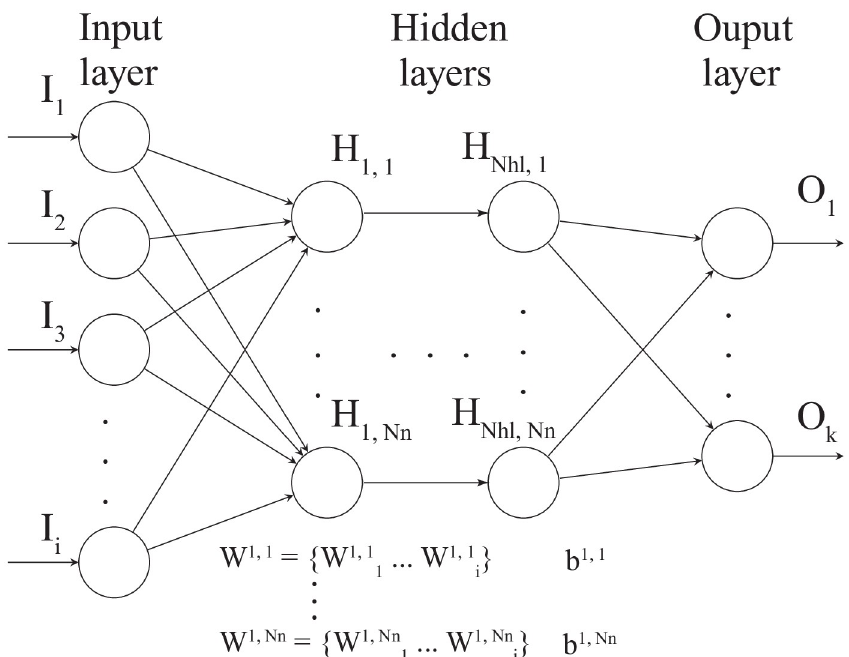
Fig 1. General neural network architecture used in this study [33, 43, 44]. The input layer contains up to i input nodes, and the output layer is composed of 1, ... , k output nodes. N hidden layer is composed of N n neurons. Each neuron (e.g., H 1,1 ... H layer with adjustable weights and also has an adjustable